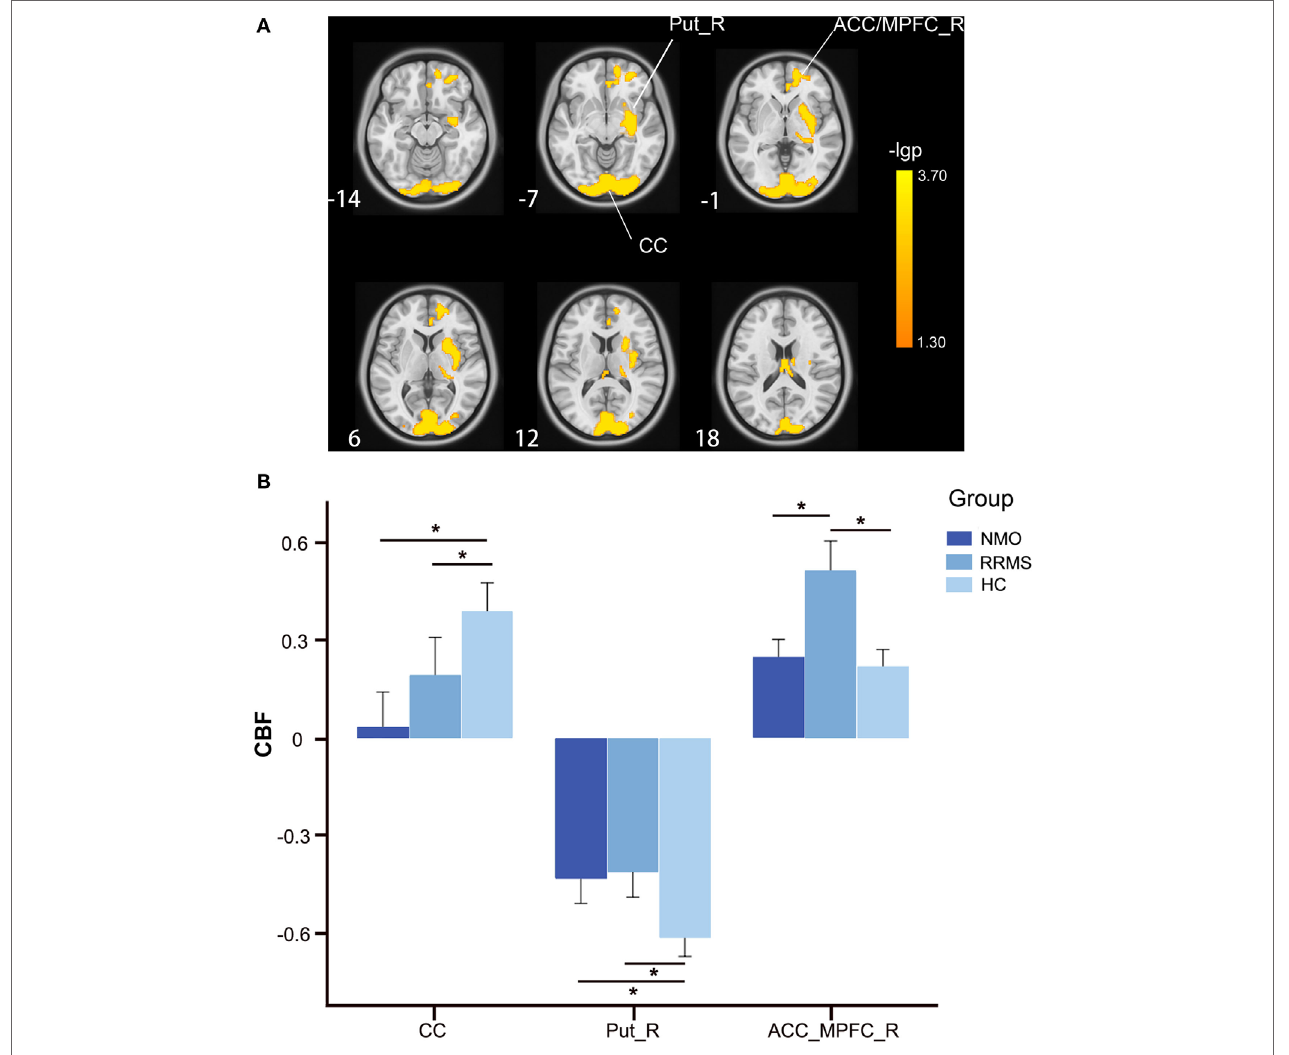
FigUre 2 | CBF differences among the relapsing-remitting multiple sclerosis, NMO, and control groups after GMV correction ( P < 0.05, FWE-corrected). (a) Voxel-based analysis shows brain regions with significant CBF differences among the three groups using age and gender as nuisance variables ( P < 0.05, FWE-corrected). (B) Bar plots show CBF differences between every two groups. Error bars are SEs. * P < 0.05. Abbreviations: ACC, anterior cingulate cortex; CBF, cerebral blood flow; CC, calcarine cortex; FWE, family-wise error; L, left; MPFC, medial prefrontal cortex; Put, putamen; R, right; GMV, gray matter